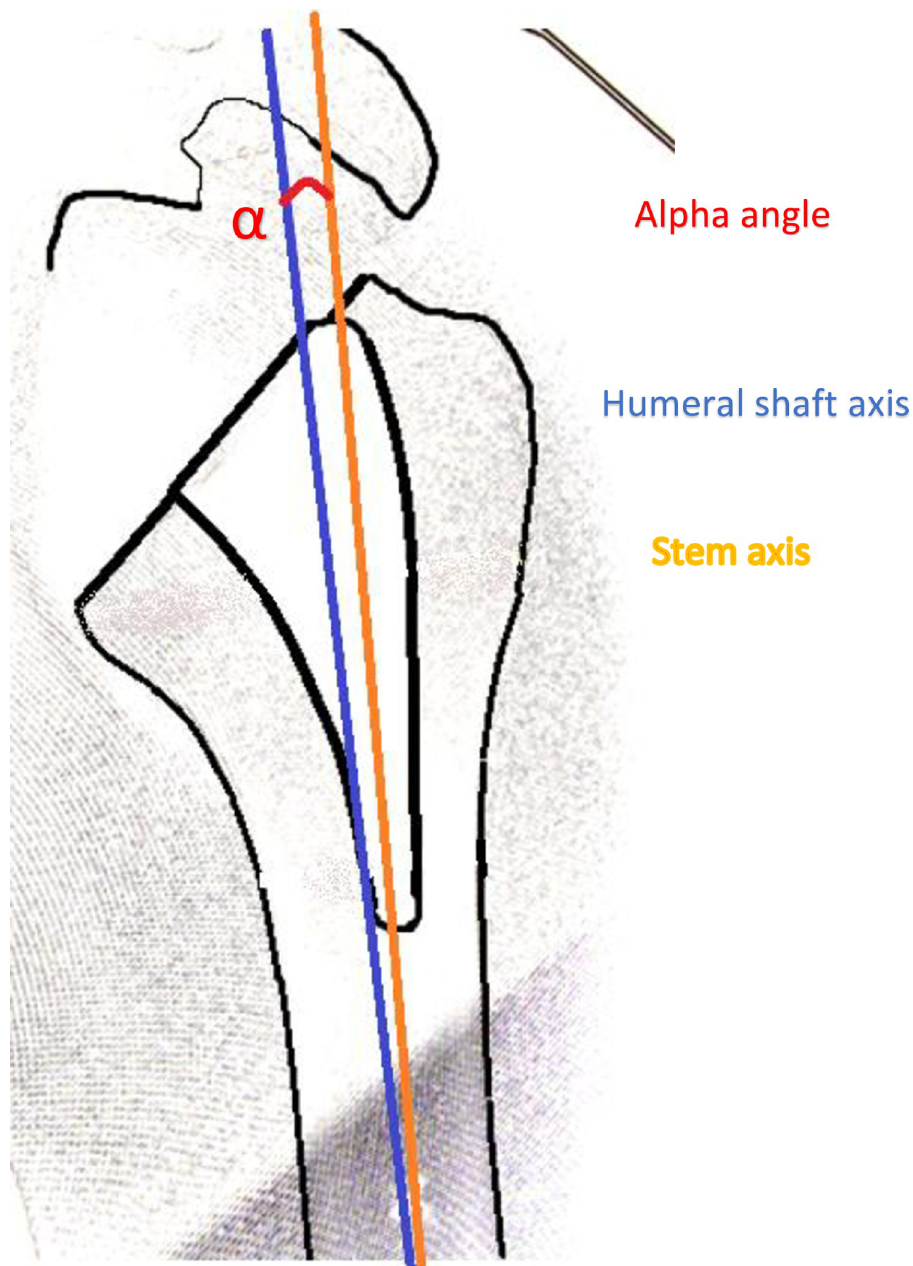
Fig 2. Humeral draw of anteroposterior radiograph. Stem axis deviation obtained by measuring the alpha angle (red circle, ) between the axis of the stem (orange line, ) and the axis of the humeral shaft (blue line,